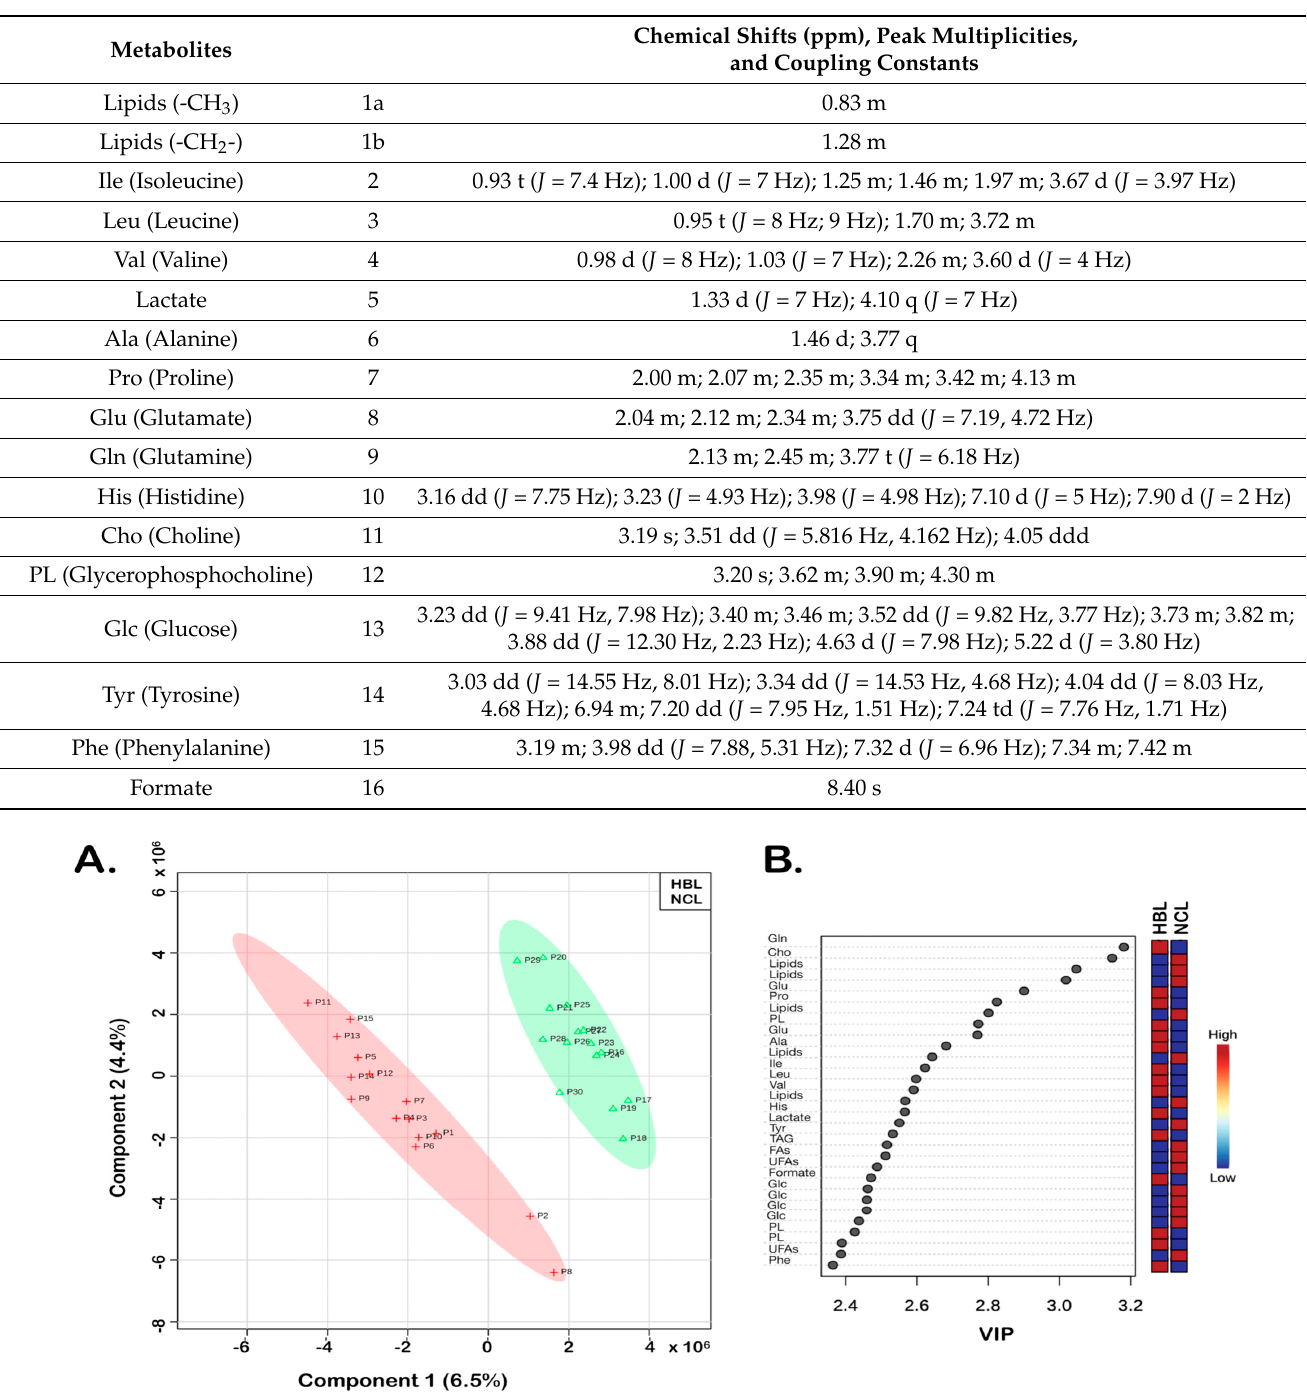
Table 1. Chemical shifts, spectral peaks’ multiplicities, and coupling constants of the 16 most important biomarkers in HBLs.